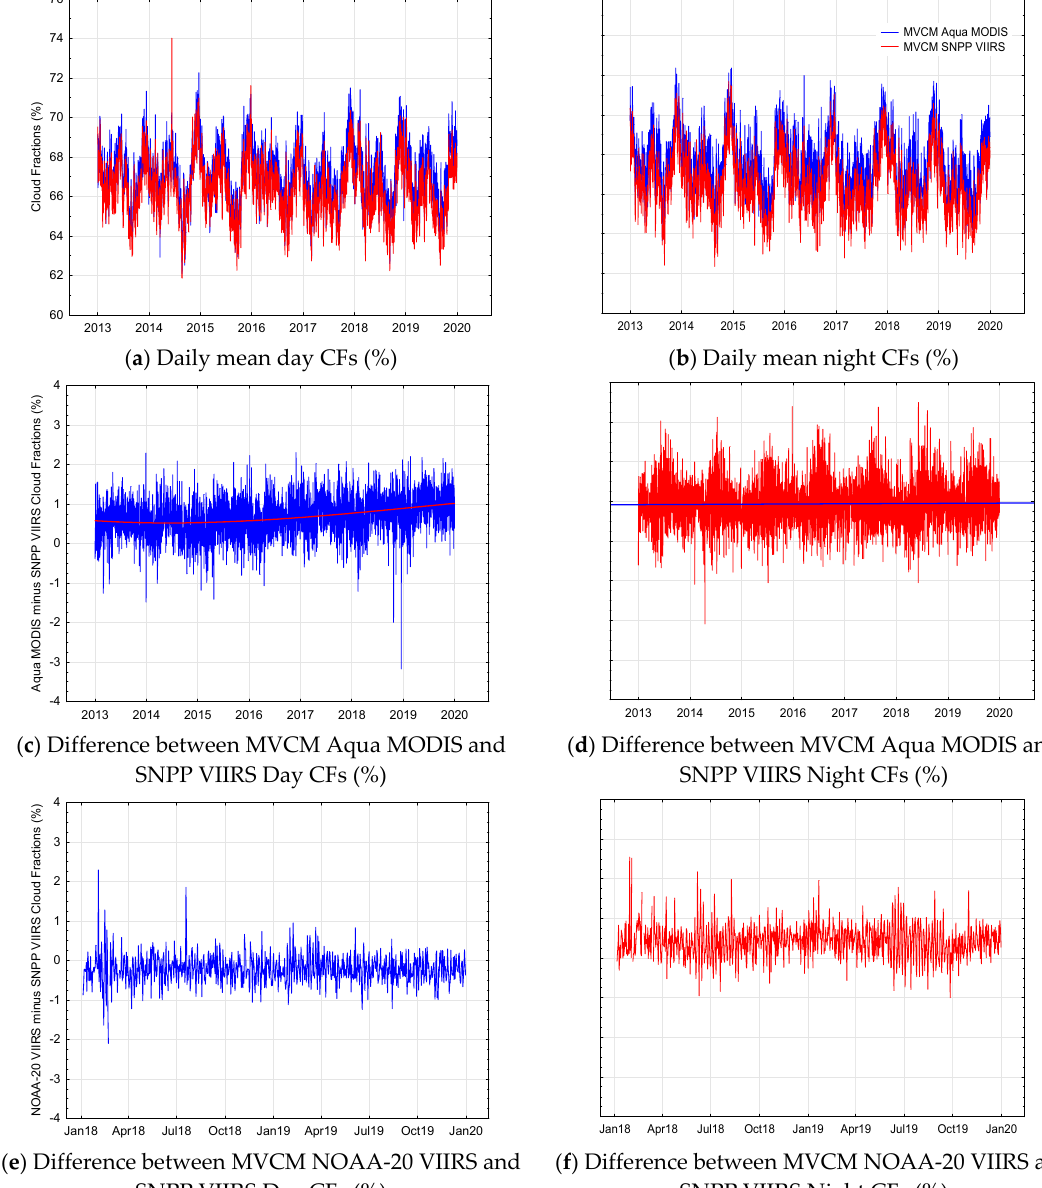
Figure 3. MVCM MODIS and VIIRS time series statistics (60S–60N); ( a ) daily mean daytime cloud fractions (CFs) for MVCM Aqua MODIS (blue) and MVCM SNPP VIIRS (red); ( b ) daily mean nighttime CFs for MVCM Aqua MODIS (blue) and MVCM SNPP VIIRS (red); ( c ) daytime CF differences between MVCM Aqua MODIS and MVCM SNPP VIIRS, ( d ) nighttime CF differences between MVCM Aqua MODIS and MVCM SNPP VIIRS; ( e ) daytime CF differences between MVCM SNPP VIIRS and MVCM NOAA-20 VIIRS; ( f ) nighttime CF differences between MVCM SNPP VIIRS and MVCM NOAA-20 VIIRS.